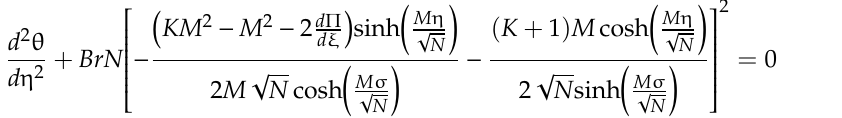
Table 2. E ff ect of M by fixing ζ = 2, K = 0.3, β = H 0